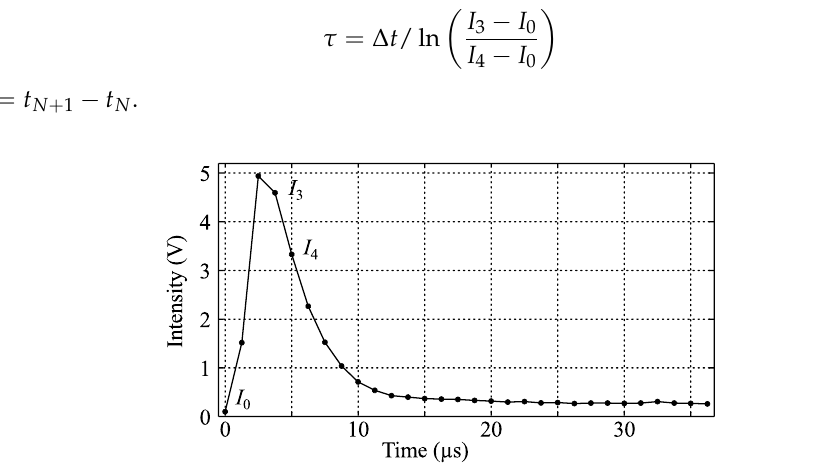
Figure 8. Typical temporal behavior of luminescent